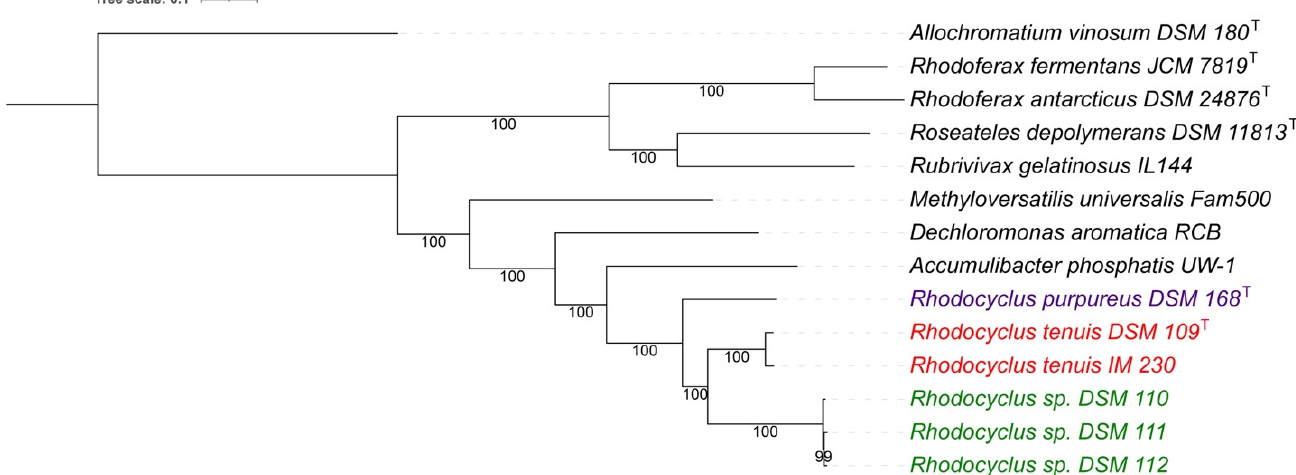
Figure 1. Whole-genome-based phylogenetic tree of all known Rhodocyclus , compared to representa- tive genomes of close relatives. One hundred rounds of the ‘Rapid bootstrapping’ option of RaxML were used to generate the support values for the phylogenetic tree. The branch length tree scale is defined as the mean number of substitutions per site, which is an average across both nucleotide and amino acid changes. The Rhodocyclus genomes are colored differently based on their ANI values (with a species cutoff of 95%). Allochromatium vinosum DSM 180 T was added as an outgroup.